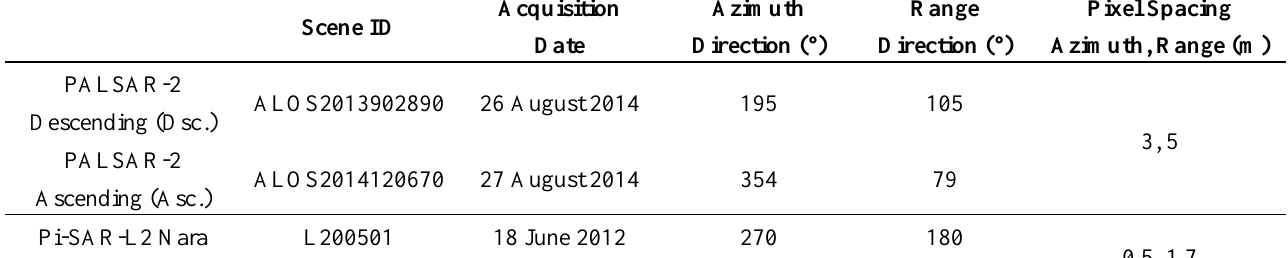
Table 1. Description of the PolSAR data. The angles of the azimuth (or flight) and range (or illumination) direction are defined as the angles from the north in the clock-wise direction. Pi, Polarimetric and Interferometric.